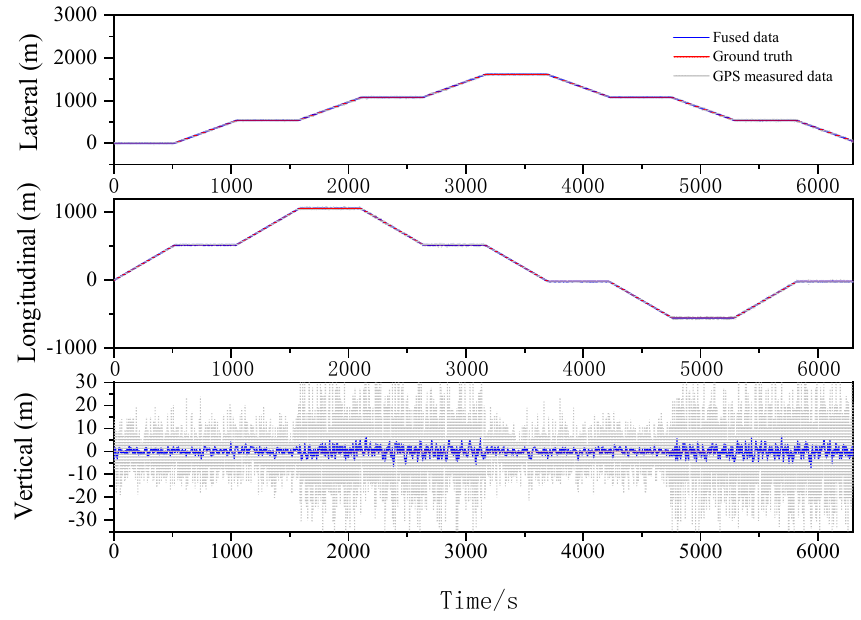
Figure 13. Motion trajectory of polygon.